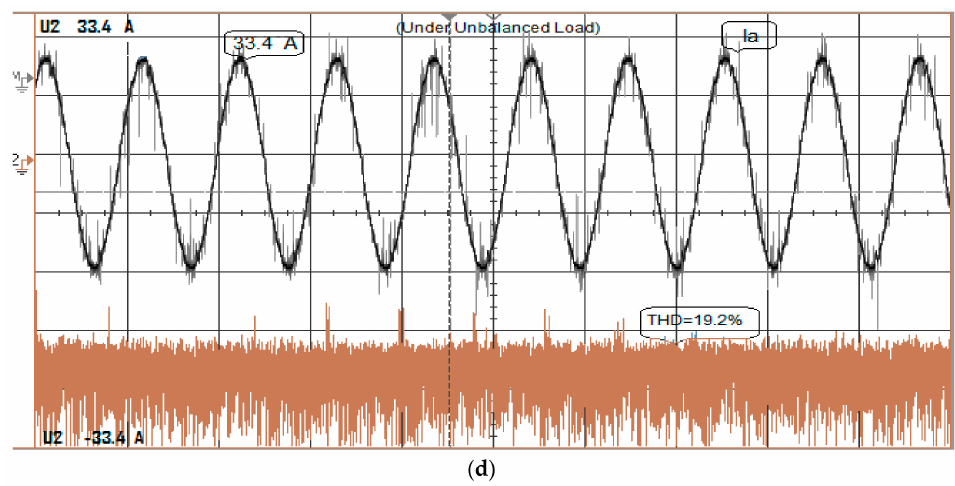
Figure 19. Inverter output voltage and current with split inductor for different load ( a ) phase-A voltage with balanced load; ( b ) phase-A current with balanced load; ( c ) phase-A voltage with unbalanced load; and ( d ) phase-A current with unbalanced load.